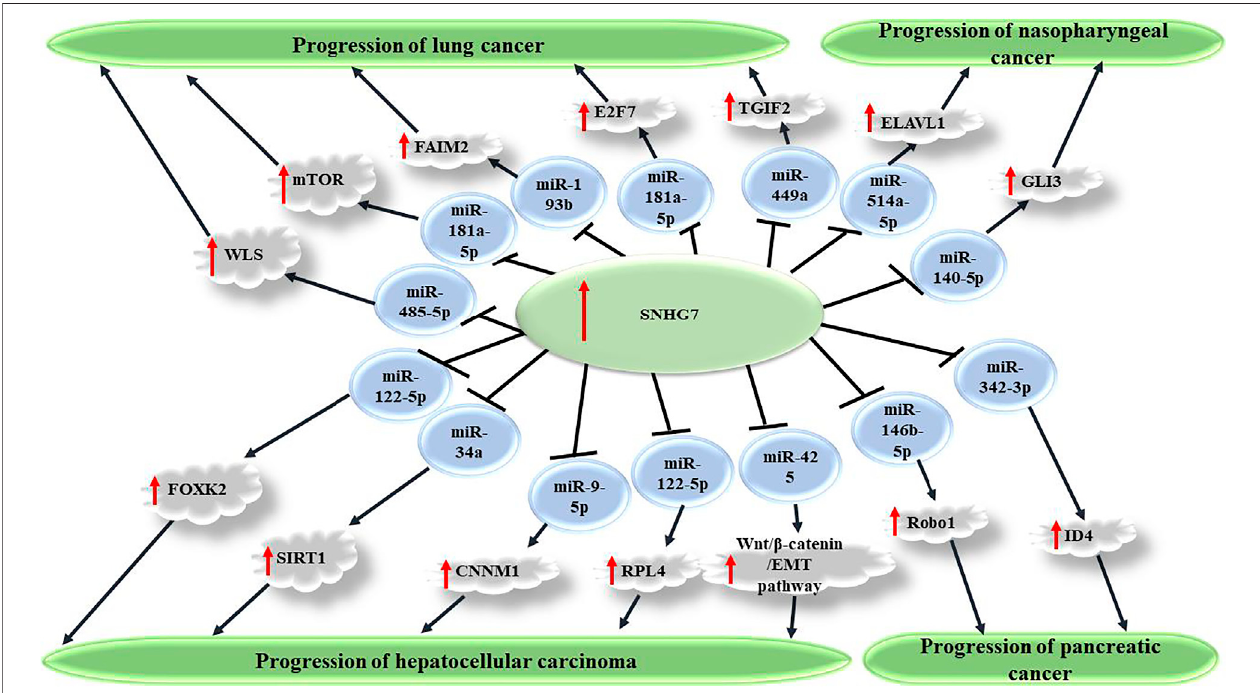
FIGURE2| SignalingpathwaysandcellularprocessesareaffectedbySNHG7toenhancetumorprogressionincancercells.ThroughspongingmiR-34a,SNHG7 activates several signaling pathways, such as Notch-1 and PI3K/Akt/mTOR in breast and colorectal cancer, respectively. Other pathways, such as Wnt/b-catenin and K-ras/ERK/cyclinD1, are also affected via other target miRNAs. The effect of SNHG7 on enhancement of glycolysis through upregulation of lactate dehydrogenase A (LDHA) has bene fi cial effects for cancer cells metabolism.